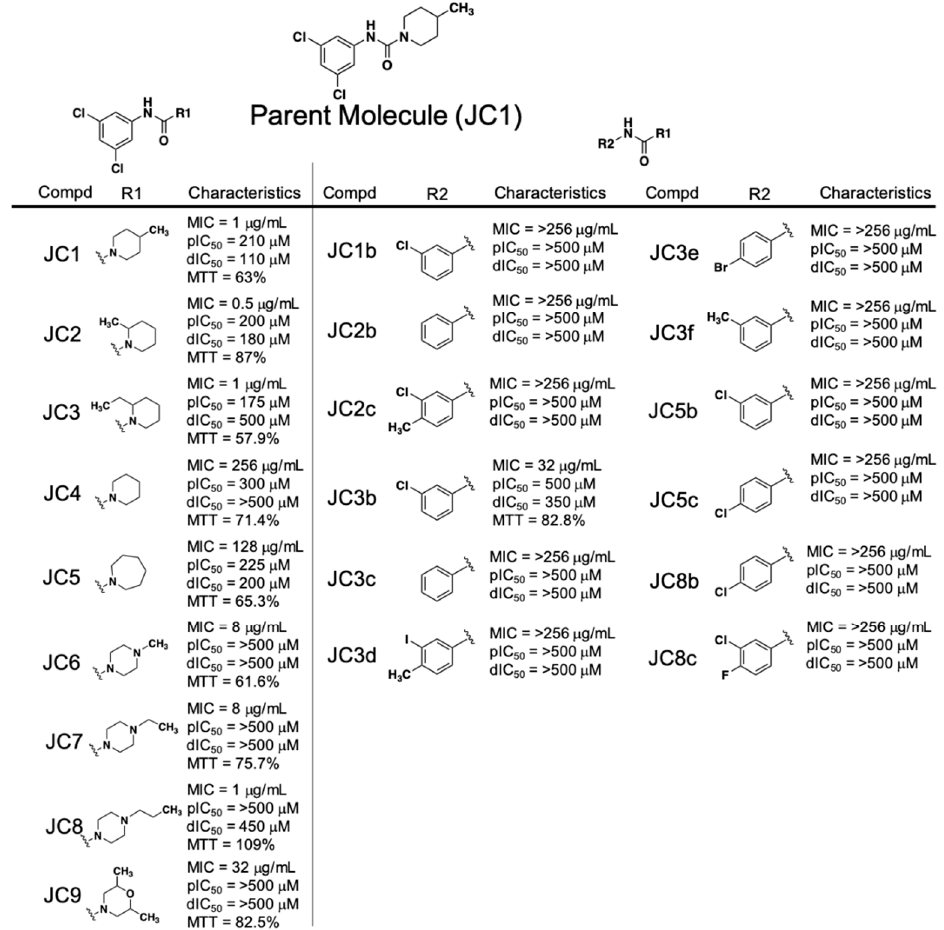
Figure 2. Piperidinecarboxamide (JC) class SAR compound characteristics. dIC 50 = degradation IC 50 ; pIC 50 = processing IC 50 ; MTT = % HepG2 cell survival after 4 × MIC exposure for 24 h. * MTT cannot be performed for compounds with MICs >256 µg/mL.